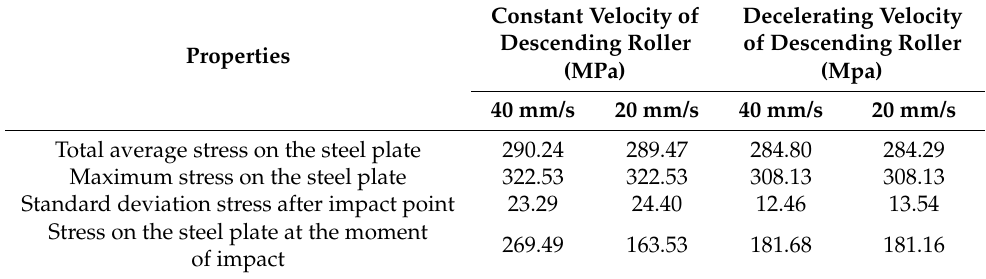
Table 2. Stress simulation results.